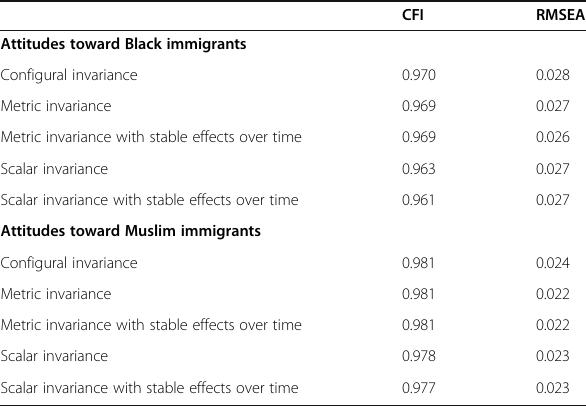
Table 6 Global fit measures from the multigroup SCFA testing